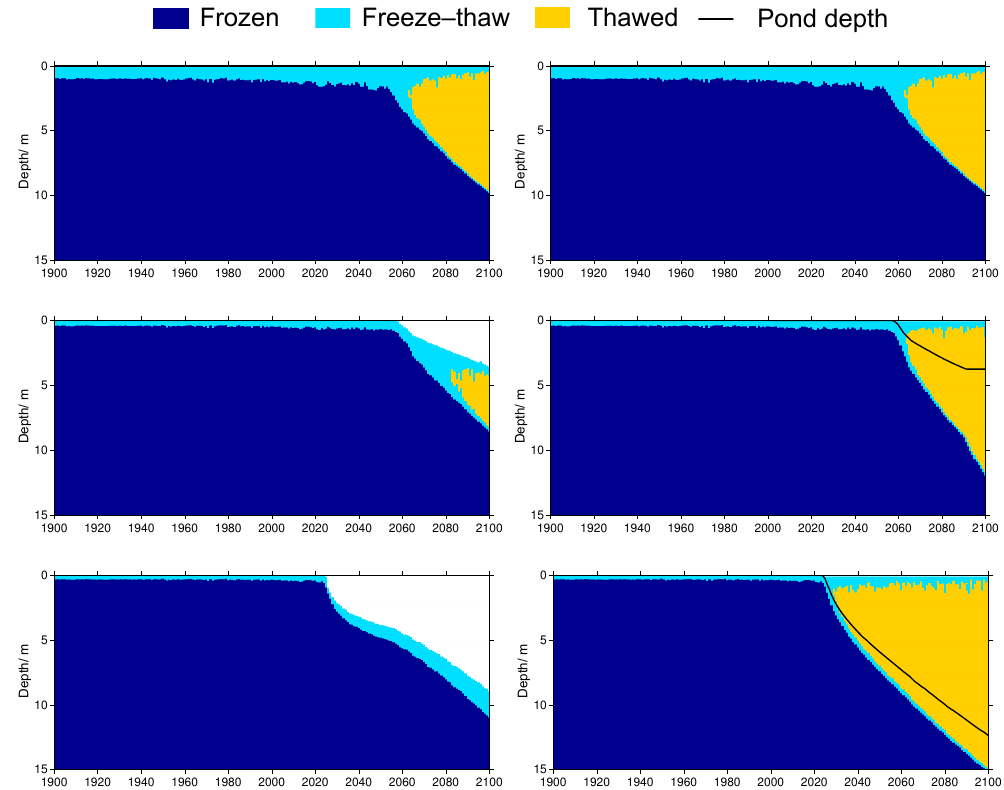
Figure 8. Annual freeze–thaw state for three different cryostratigraphies (top to bottom: Arga, Samoylov, ice complex) and the drainage scenarios subsidence (left) and thermokarst (right), as simulated by CryoGrid 3 Xice forced by CRU-NCEP/CCSM4 and the future warming scenario RCP